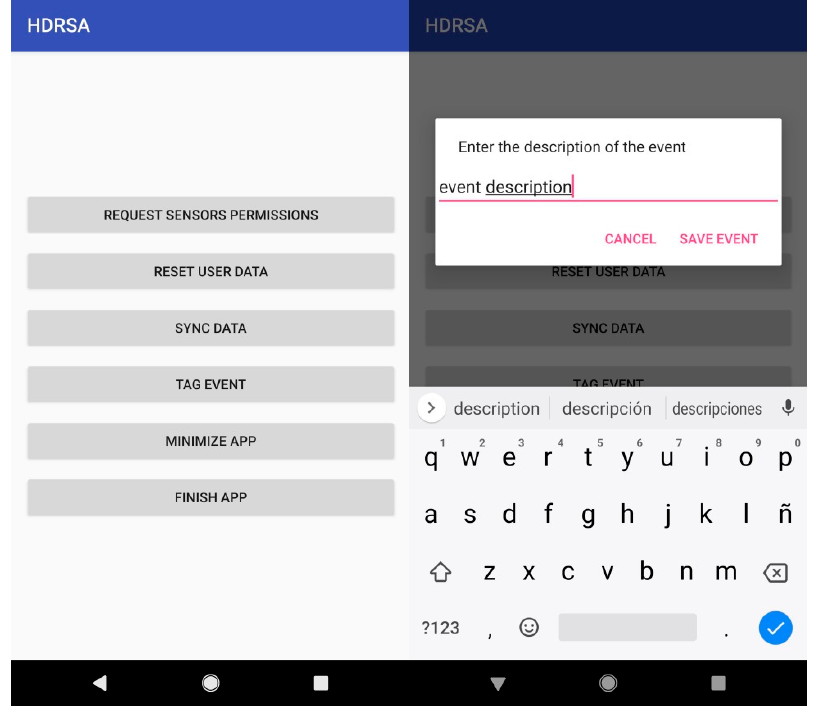
Figure 2. Mobile application HDRS tag event.